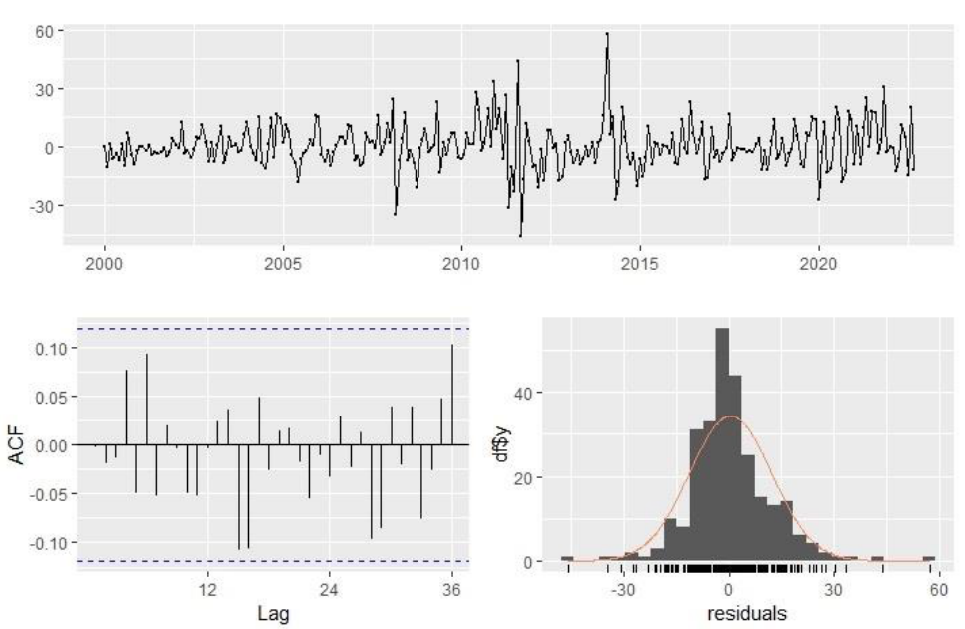
Figure A1. Residuals, ACF, and lags in prediction of Coffee. Own processing.